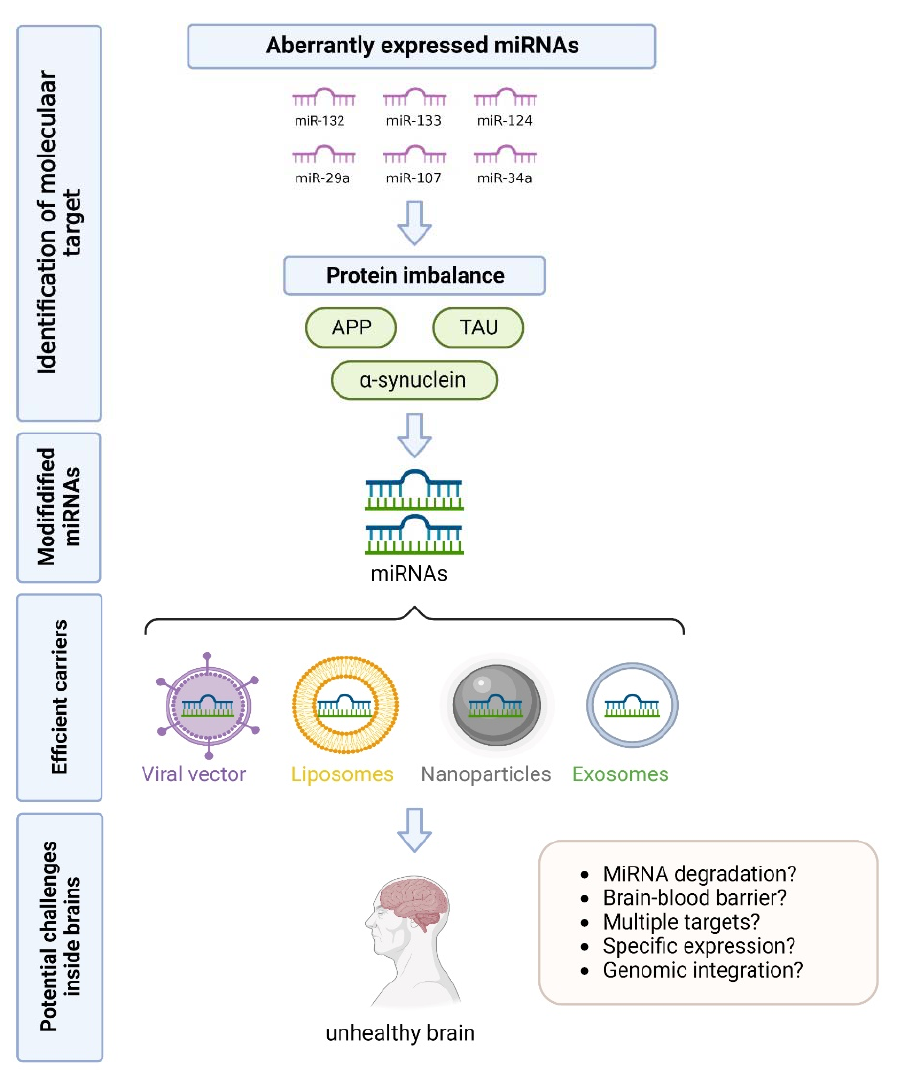
Figure 2. Possible challenges of miRNA ‐ based diagnostics in neurodegenerative diseases.